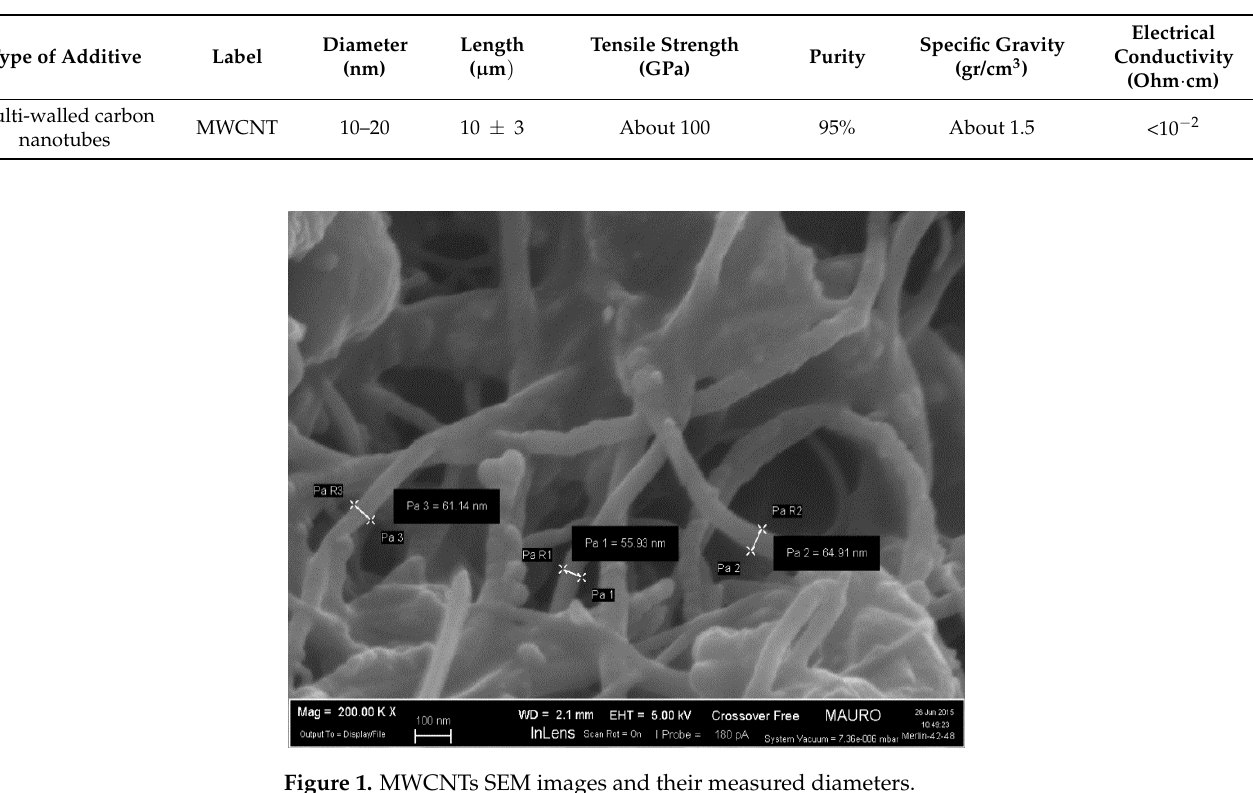
Table 1. Properties of MWCNTs.